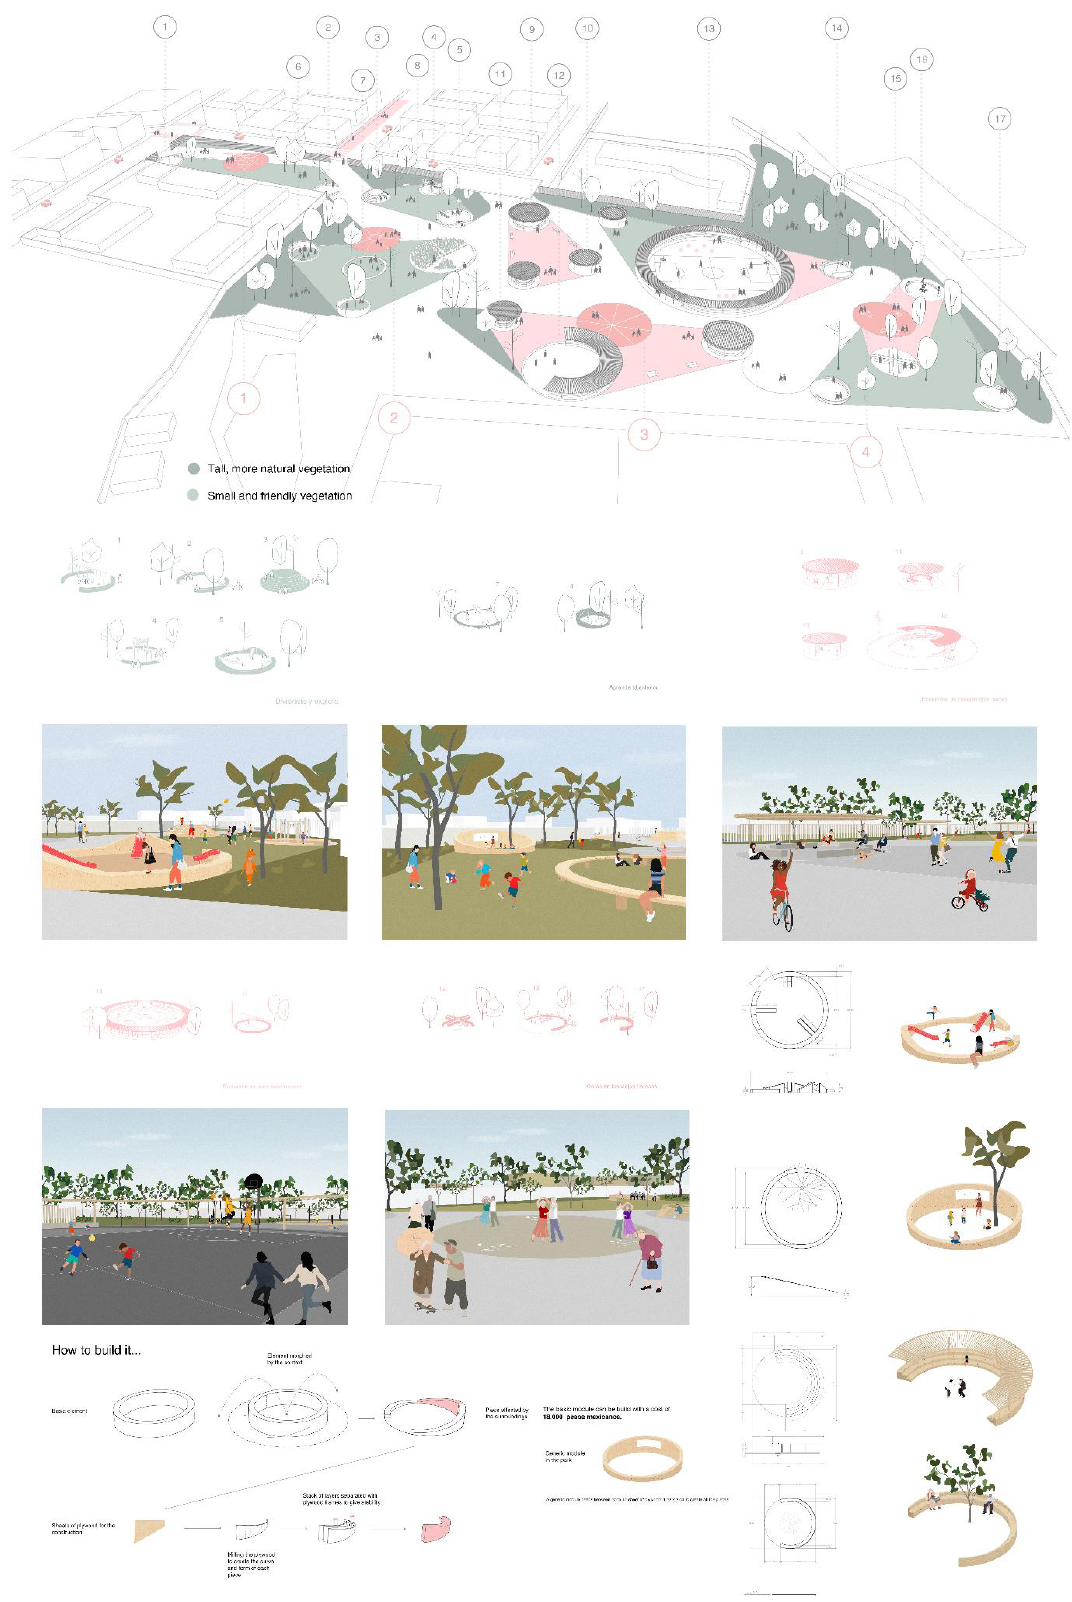
Figure 4. Learning/recreations zone, by Gerardo Yabur and Abigail Zavaleta.